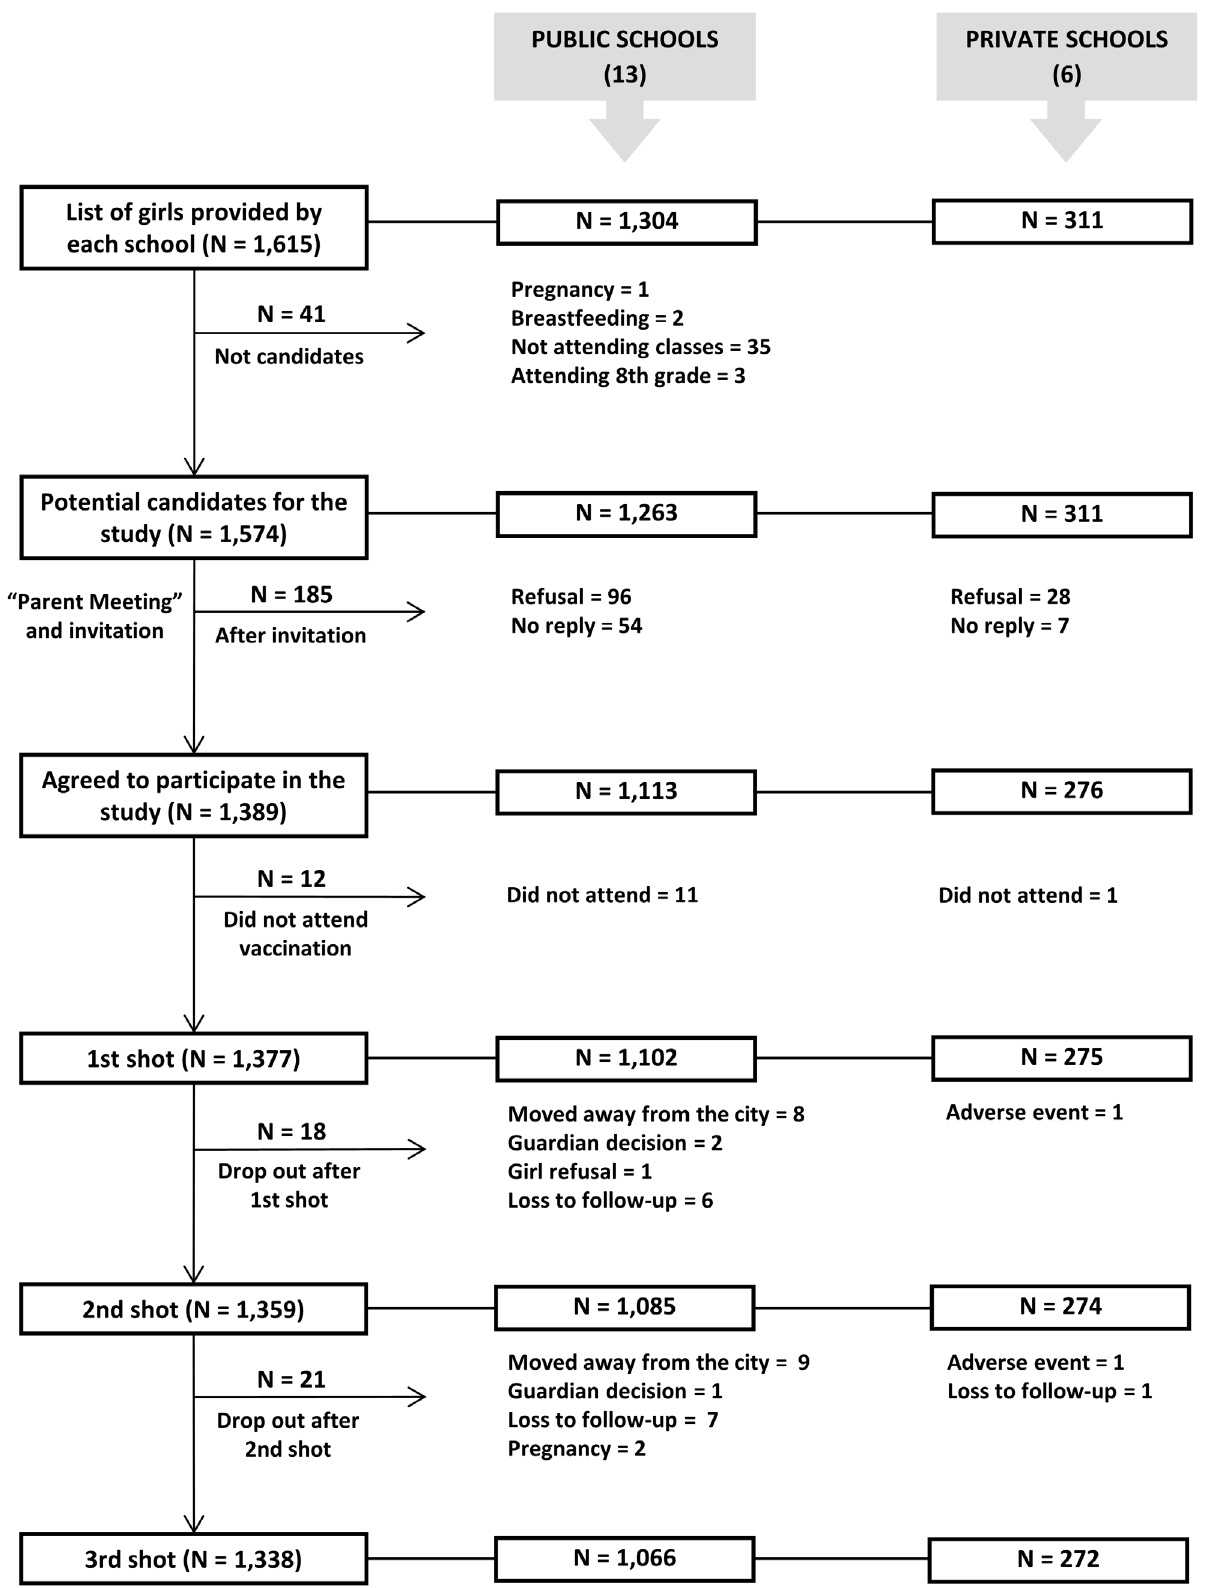
Figure 1. Distribution of girls throughout the study.